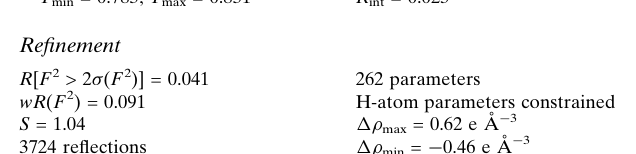
Bruker APEX CCD diffractometer Absorption correction: